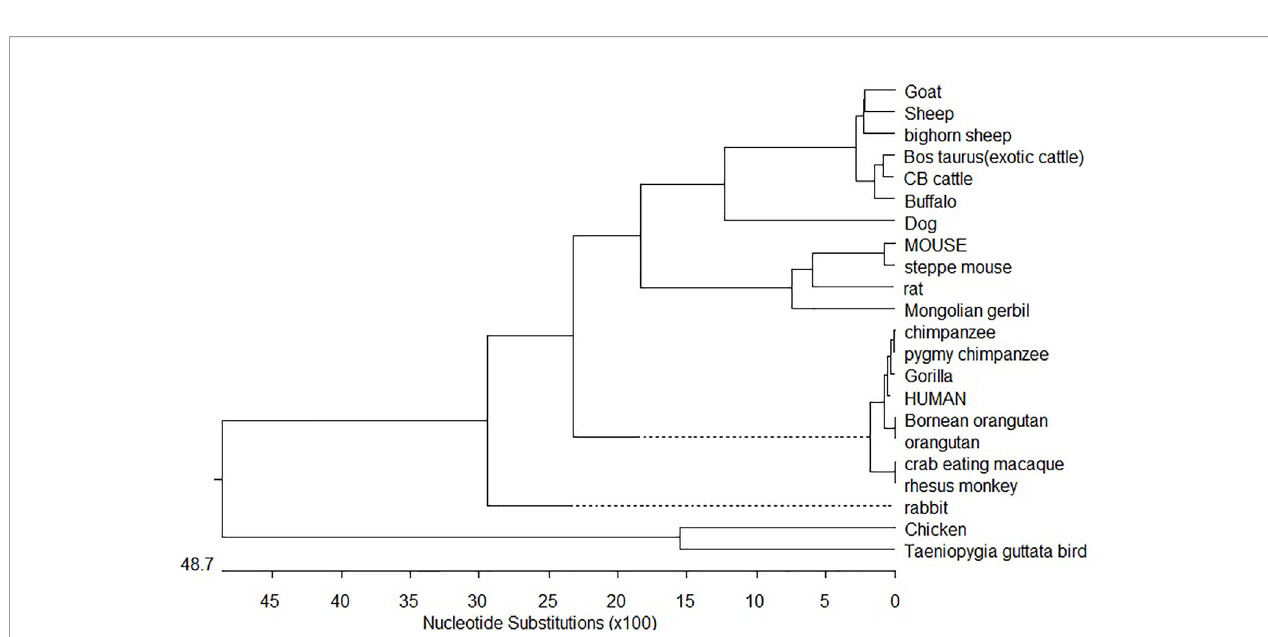
FIGURE 8 | Phylogenetic analysis of mammals and birds with respect to CD14 gene.